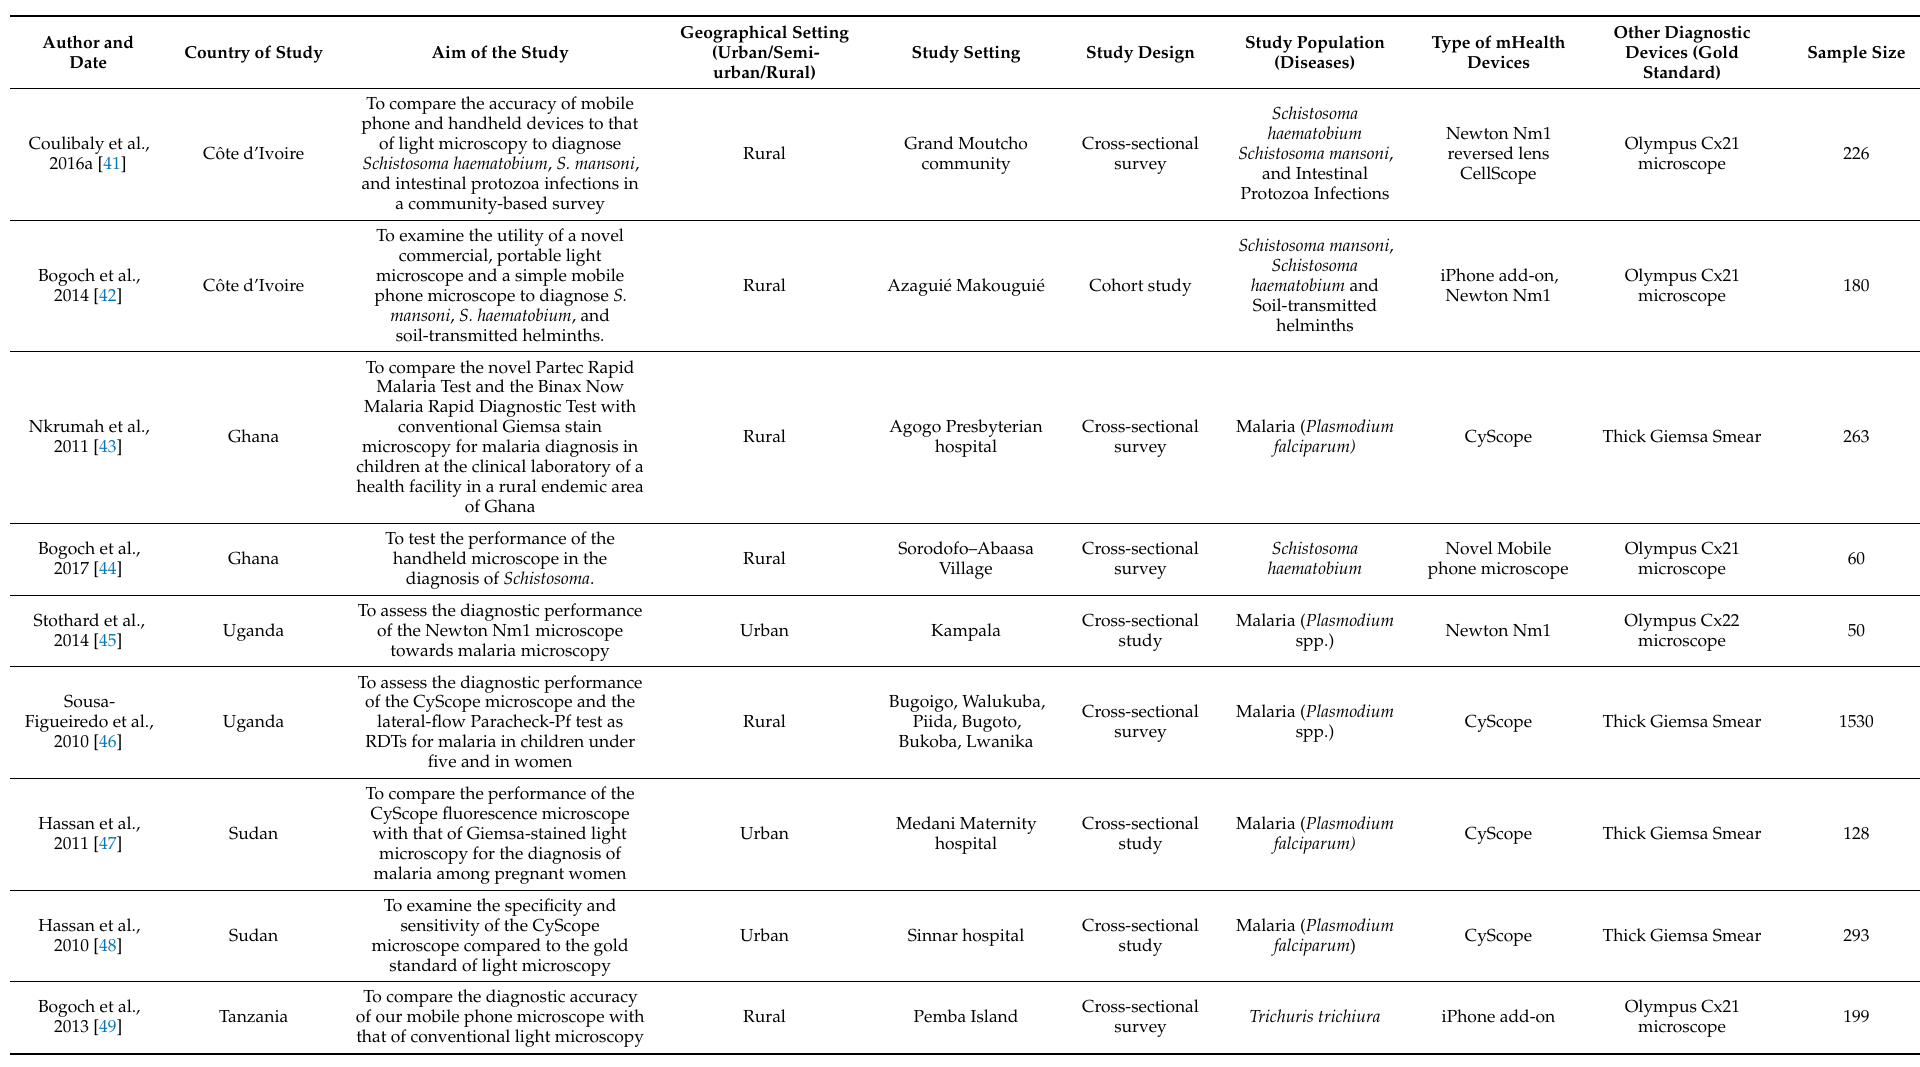
Table 2. Characteristics of the included